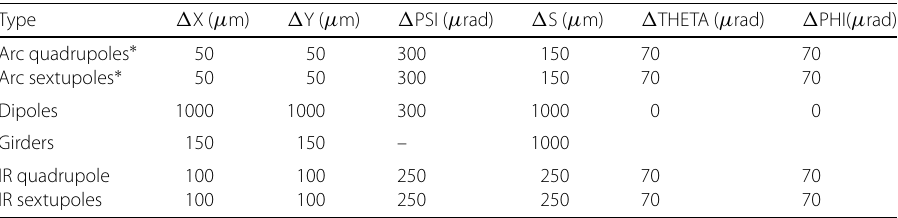
Table 2 rms misalignment values used in simulations presented in this paper. The definition of the misalignment parameters are defined in Fig. 2. Note that values are not tolerance specifications, as there is an ongoing iterative process to determine the alignment level achievable and the acceptable